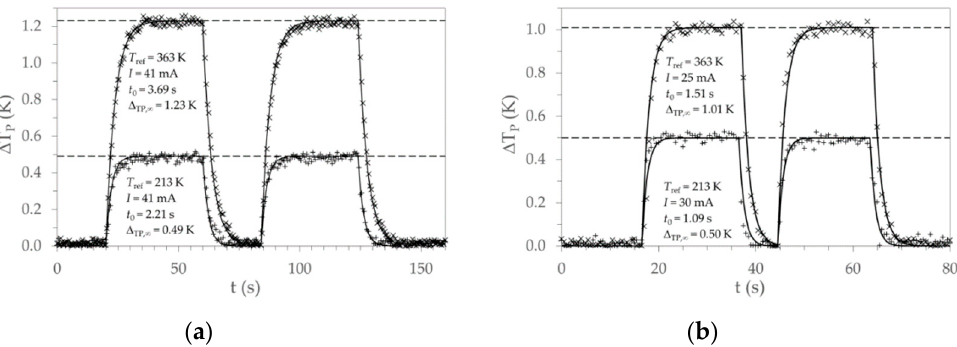
Figure 4. Examples of the transient temperature difference measured on the external surface of the ceramic plates versus time for the two cases with maximum and minimum reference temperature. Solid lines represent the trend calculated with a lumped model that uses the characteristic time t 0 provided by the DX 4090; dashed lines represent the asymptotic values ∆ T P , ∞ . ( a ) module a.2; ( b ) module c.